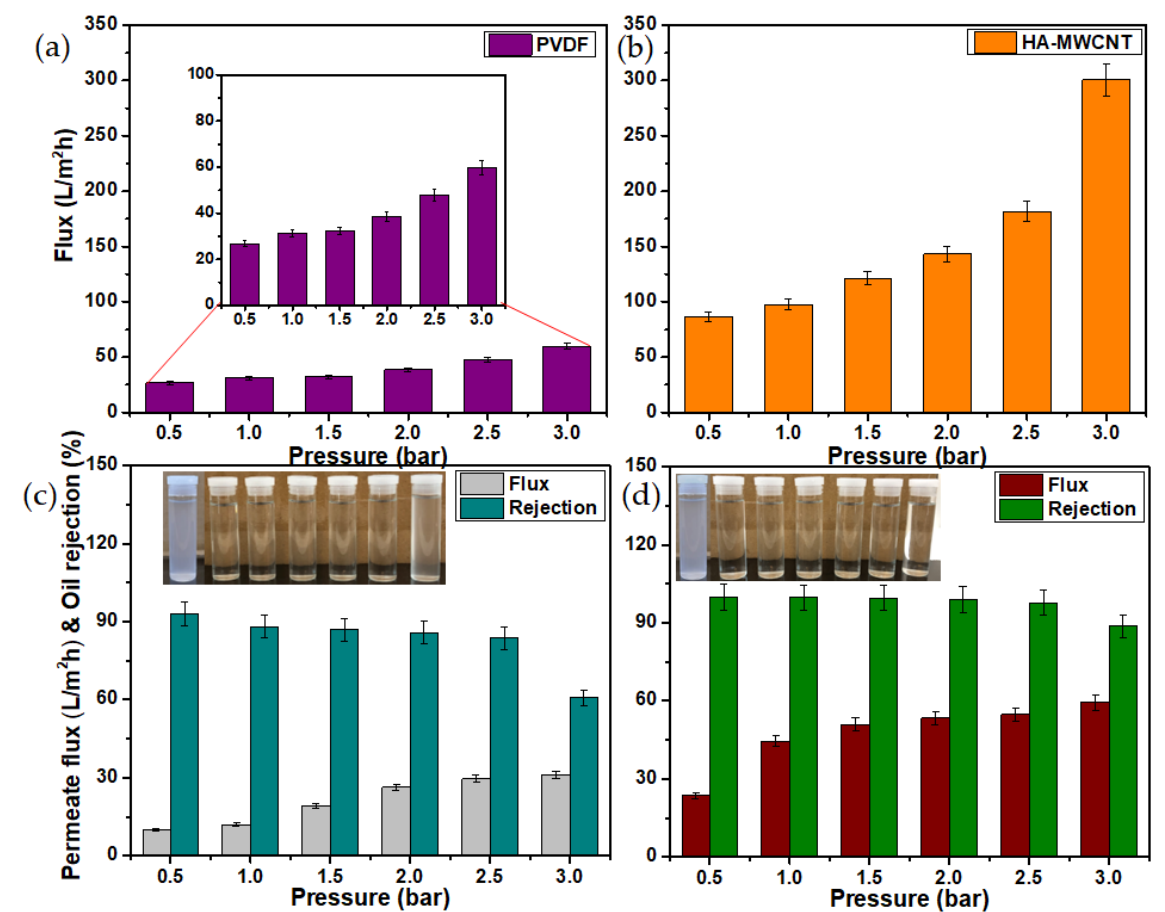
Figure 9. Water permeation flux on ( a ) pristine PVDF and ( b ) HA-MWCNT membranes. The permeate flux and the oil rejection on the pristine PVDF and the HA-MWCNT membranes are shown in ( c ) and ( d ), respectively. The snapshots of the emulsion feed and the permeate are shown as inset in ( c ) and ( d ).